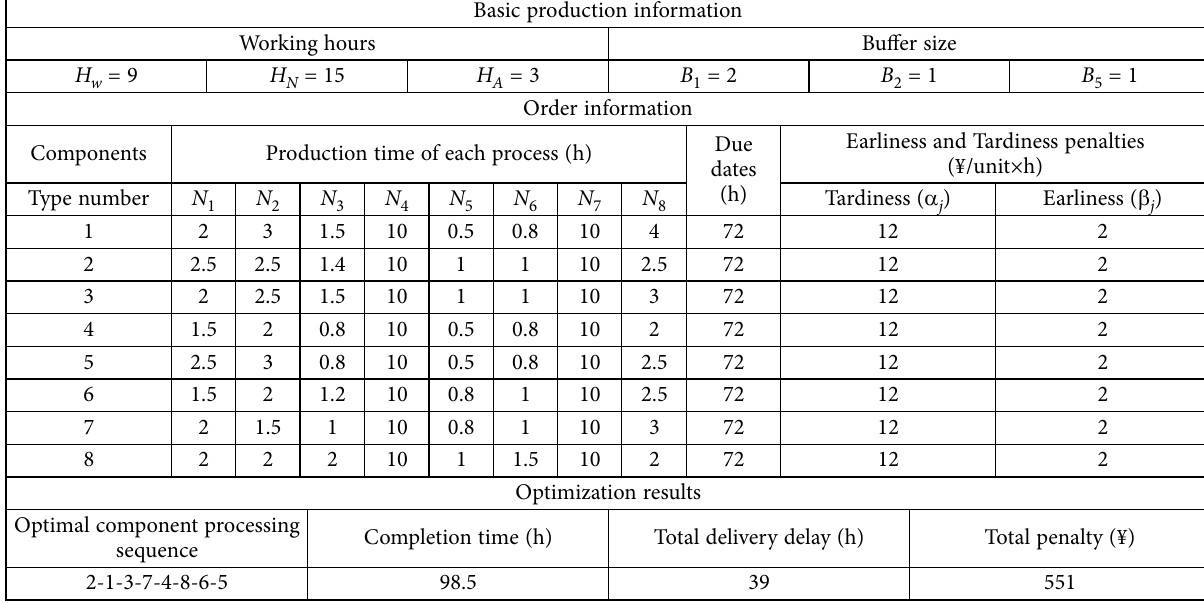
Table 7. Input data and optimization results of the 8-component case